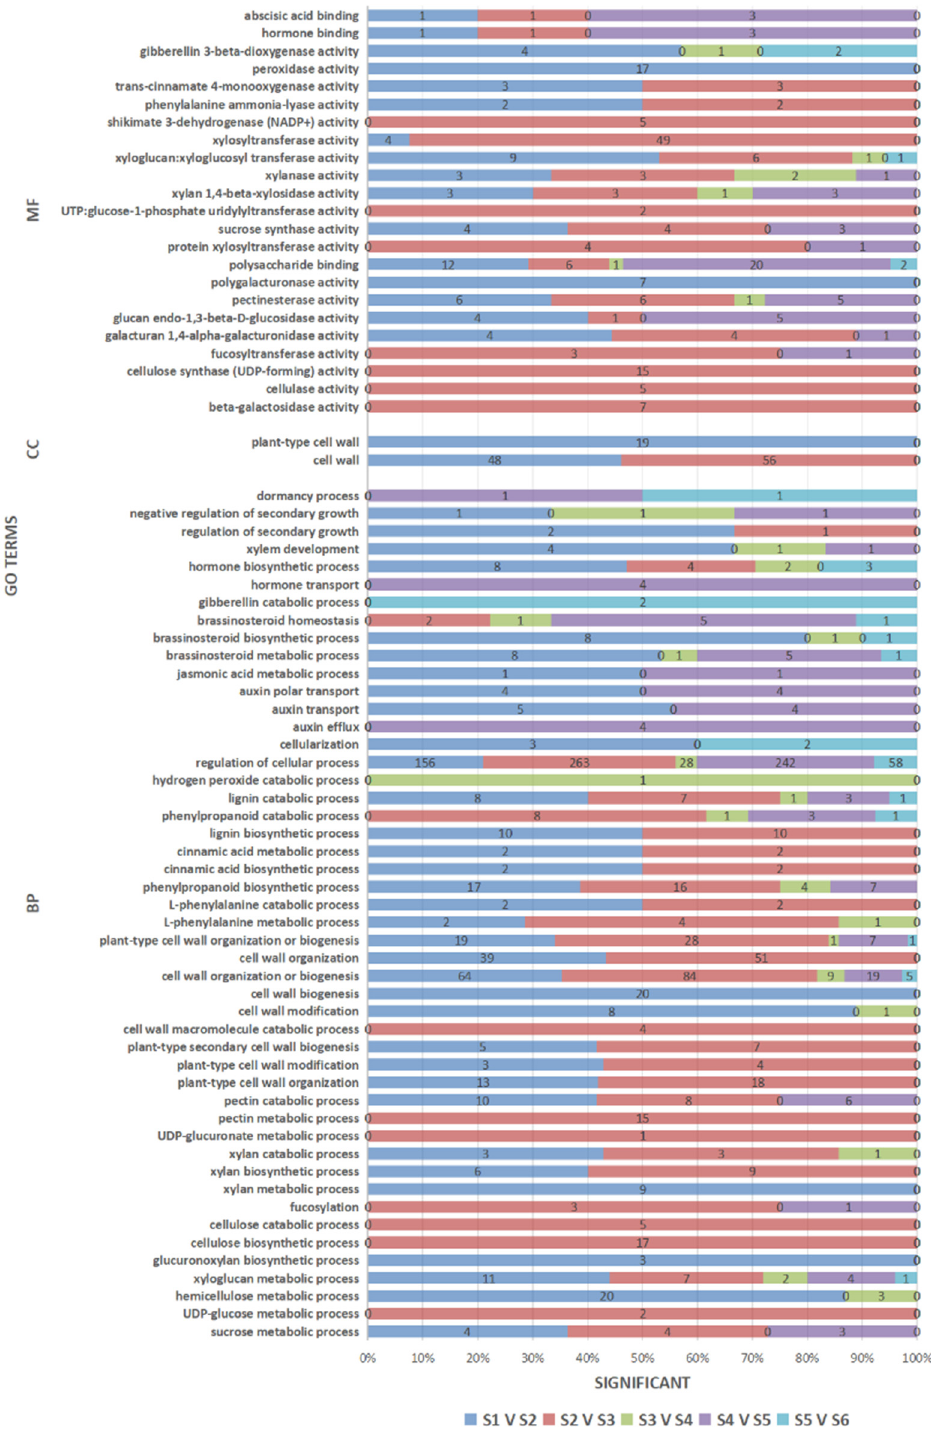
Figure 5. Distribution of the Gene Ontology (GO) terms associated with xylem development in “Shanxin” poplar after enrichment analysis of the upregulated DEGs during the seasonal change. GO terms in the three major GO ontologies are shown on the left, and the specific sample comparisons are color-coded. BP: Biological process, MF: Molecular function and CC: Cellular component. The number represents the number of enriched genes.